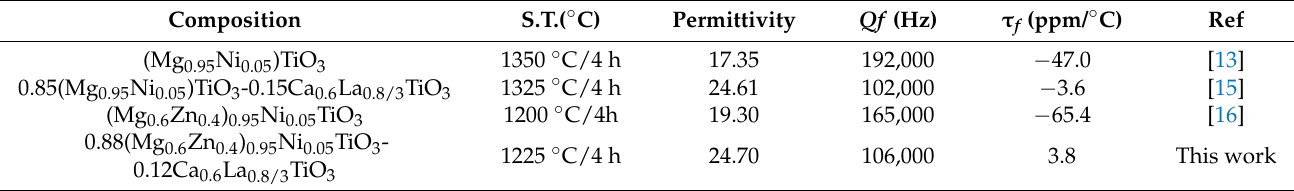
Table 2. Comparison of the proposed dielectric with other similar reported dielectric ceramics. Composition S.T.( ◦ C)